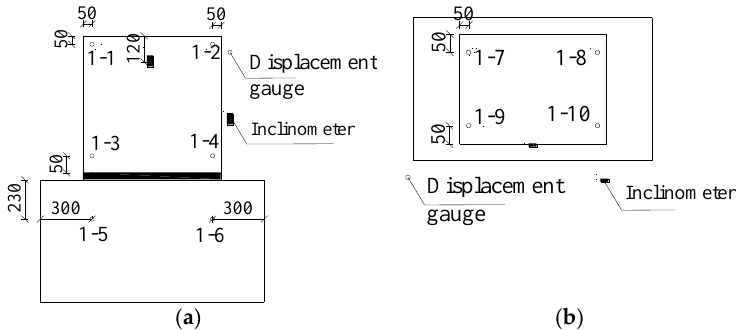
Figure 6. Arrangement of displacement meter and inclinometer (unit: mm). ( a ) Front view. ( b ) Top view.